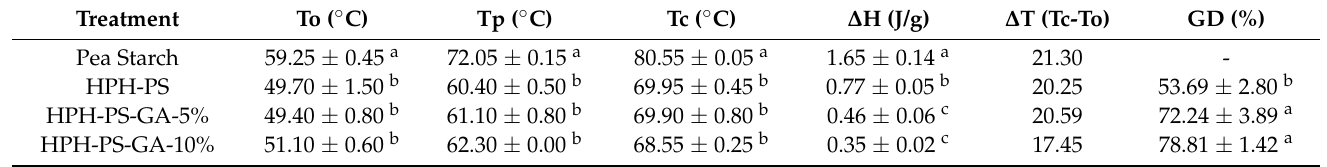
Table 1. Thermal properties and gelatinization degree of native and modified pea starch.